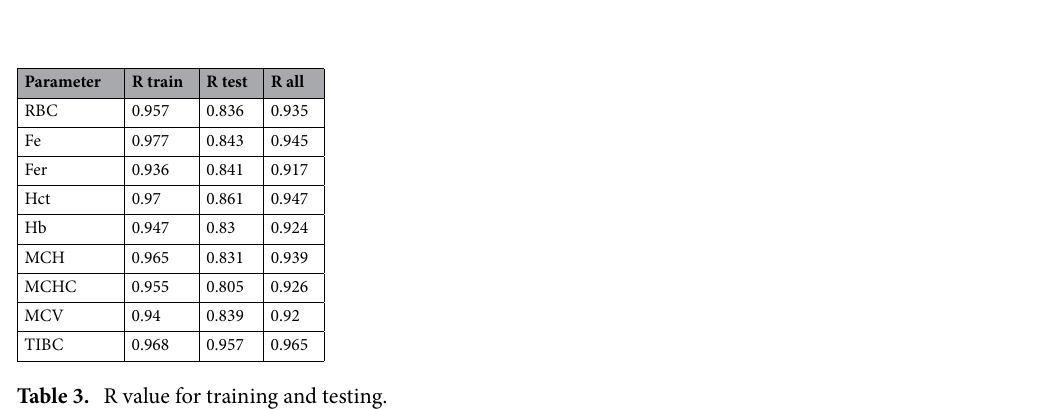
Figure 10. The absorption spectrum of the spent dialysate fluid shown as a function of hemoglobin concentration. R values for training and testing datasets are given in Table 3. The R values are very close to one another for both training and testing datasets. This means that the correlation between the network and the intended outputs does not stem from coincidence.